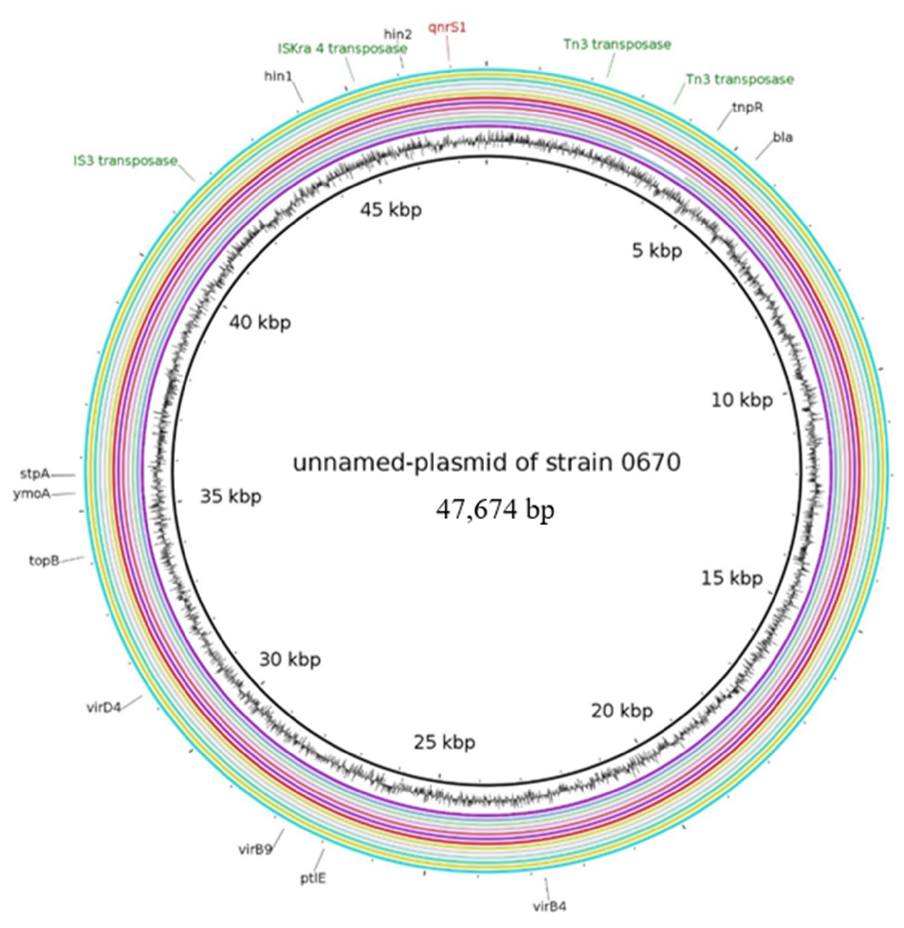
Figure 1. BRIG image of sequence contigs of individual isolates assigned to the unnamed reference plasmid (NZ_CP0200800). Contigs belonging to the isolates as indicated (from inner to outer ring): unnamed-plasmid of strain 0670, 17-AB00542, 17-AB00639, 17-AB00742, 17-AB00995, 17-AB01105, 17-AB01352, 17-AB01539, 17-AB01752, 17-AB01792, 17-AB01795, 17-AB01969, 17-AB02090, 17-AB02707 and 17-AB02951.